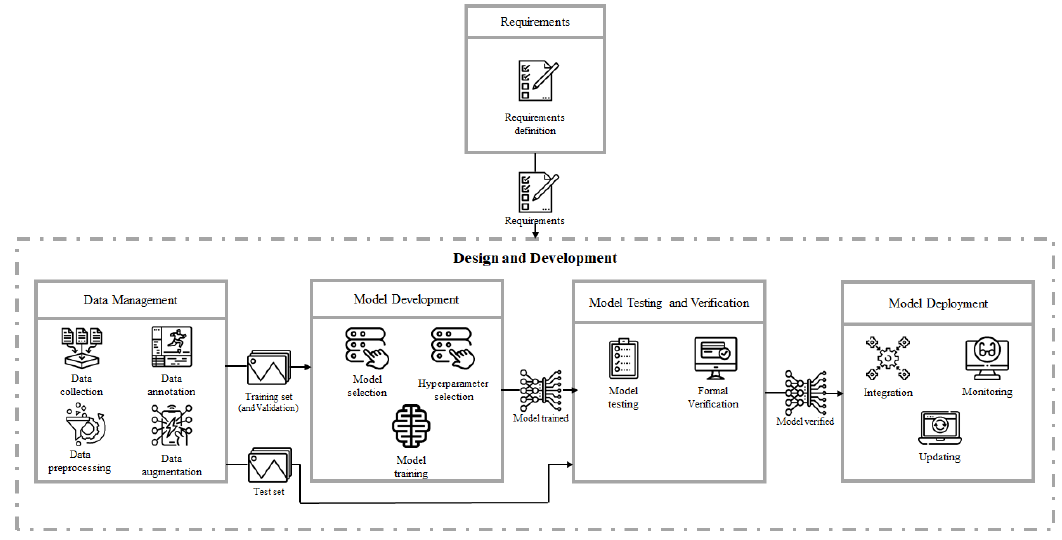
Figure 2. Machine learning lifecycle (adapted from the work of Ashmore et al.